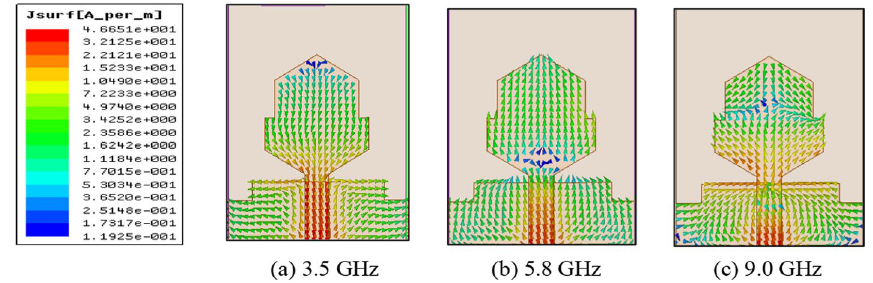
Fig. 9 Proposed antenna current distribution. The surface current distribution at 3.5 GHz, 5.8 GHz, and 9 GHz frequency is presented in a – c , respectively. At all the frequencies, almost a very good impedance matching is observed. At the antenna’s feedline, the maximum surface current is 46.65 A/m. Conversely, values are lowered with the distance apart from input